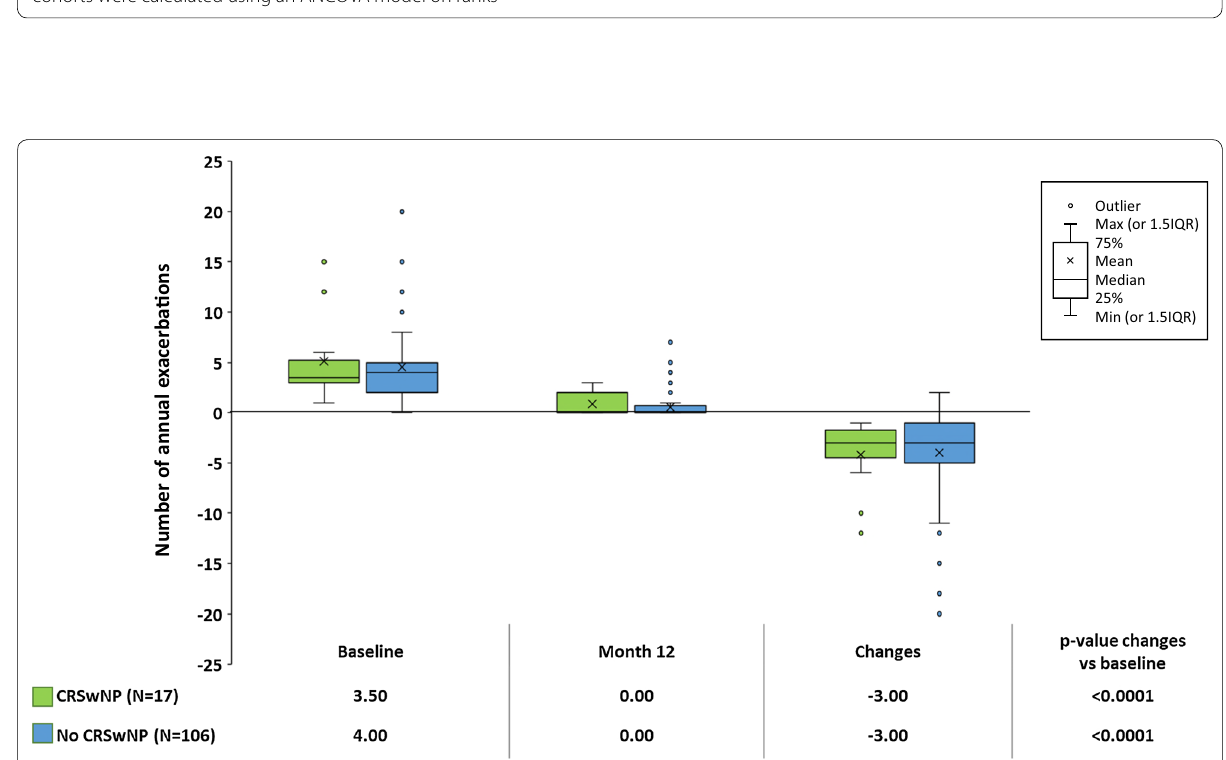
Fig. 3 The median number of annual exacerbations in the year prior to initiating omalizumab treatment (baseline) and during 12 months’ treatment with omalizumab, and change from baseline, in patients with with severe allergic asthma with chronic rhinosinusitis with nasal polyps (CRSwNP) or without CRSwNP (No CRSwNP). The p-values within cohorts were calculated using a signed rank test and p-values for comparisons between cohorts were calculated using an ANCOVA model on